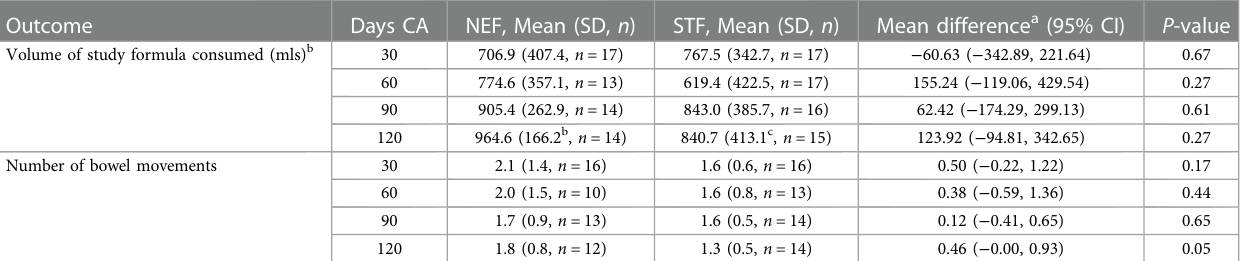
TABLE 3 Formula intake and bowel